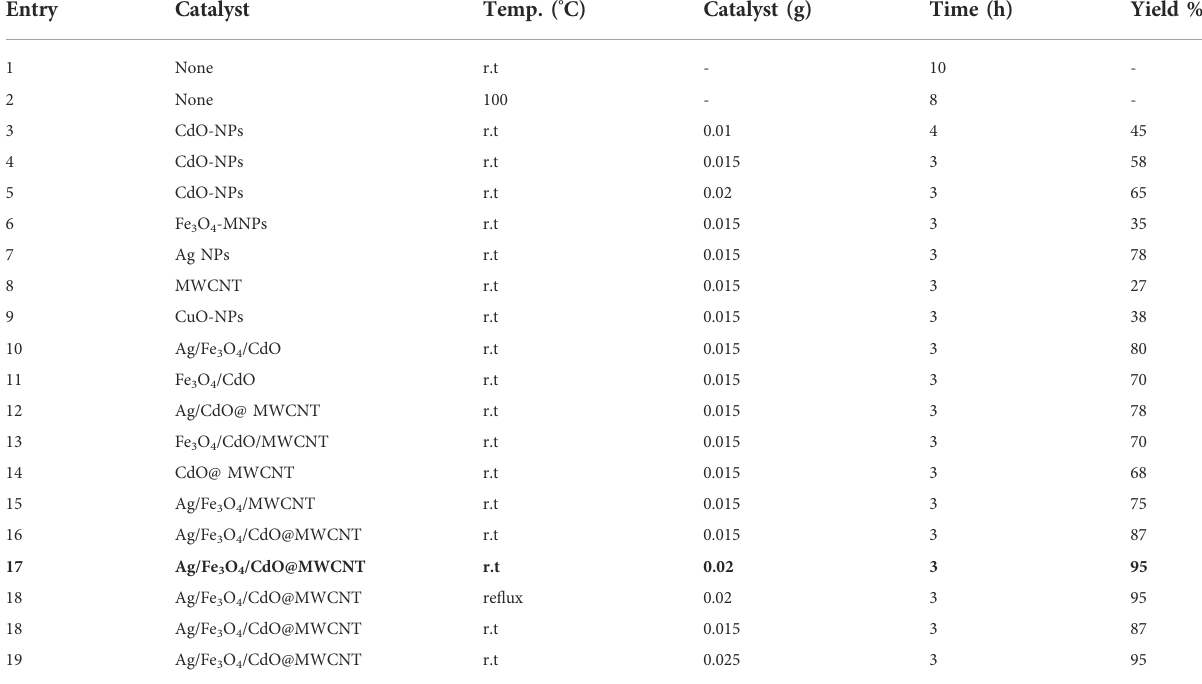
a Isolated yields. Bold indicates best condition for performing reactions.